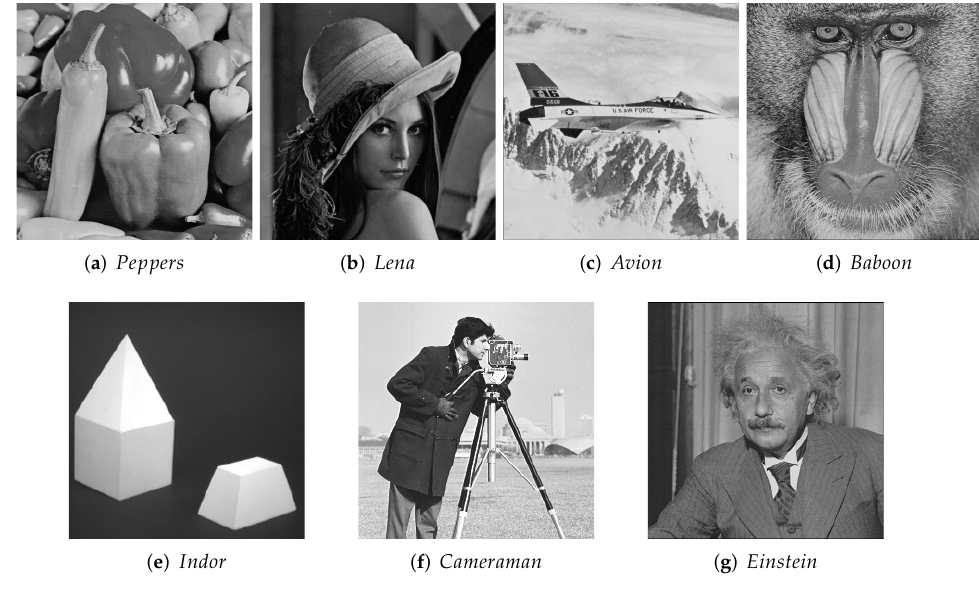
Figure 5. Relevant